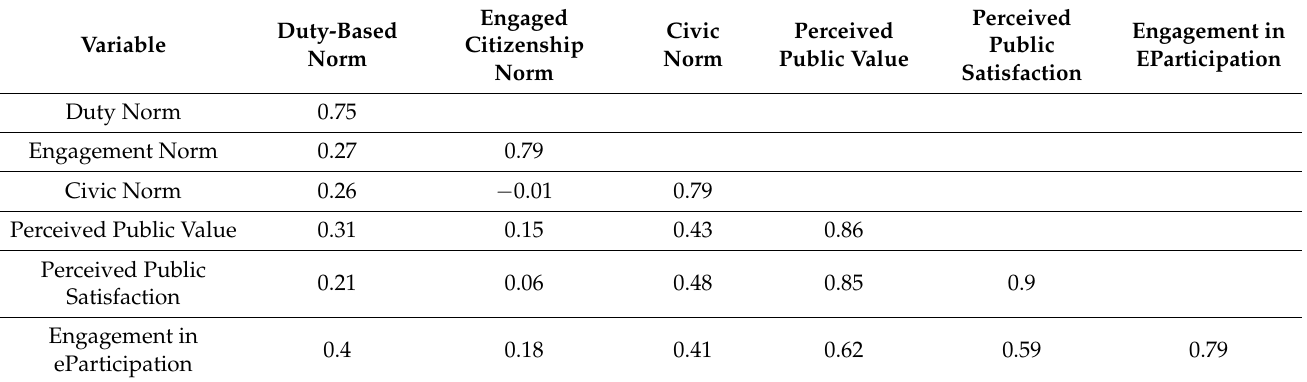
Table 4. Discriminant validity evaluation using Fornell–Larcker criterion